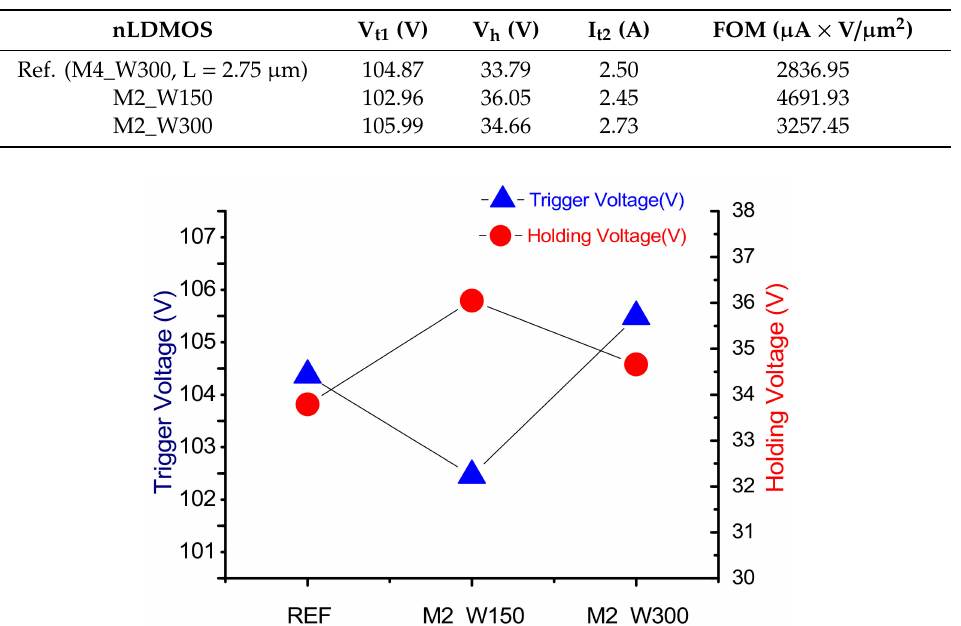
Figure 12. Snapback I-V curves and leakage currents of HV nLDMOSs with channel-width modulation. Table 3. Snapback extracted parameters of HV nLDMOSs with channel-width modulation.